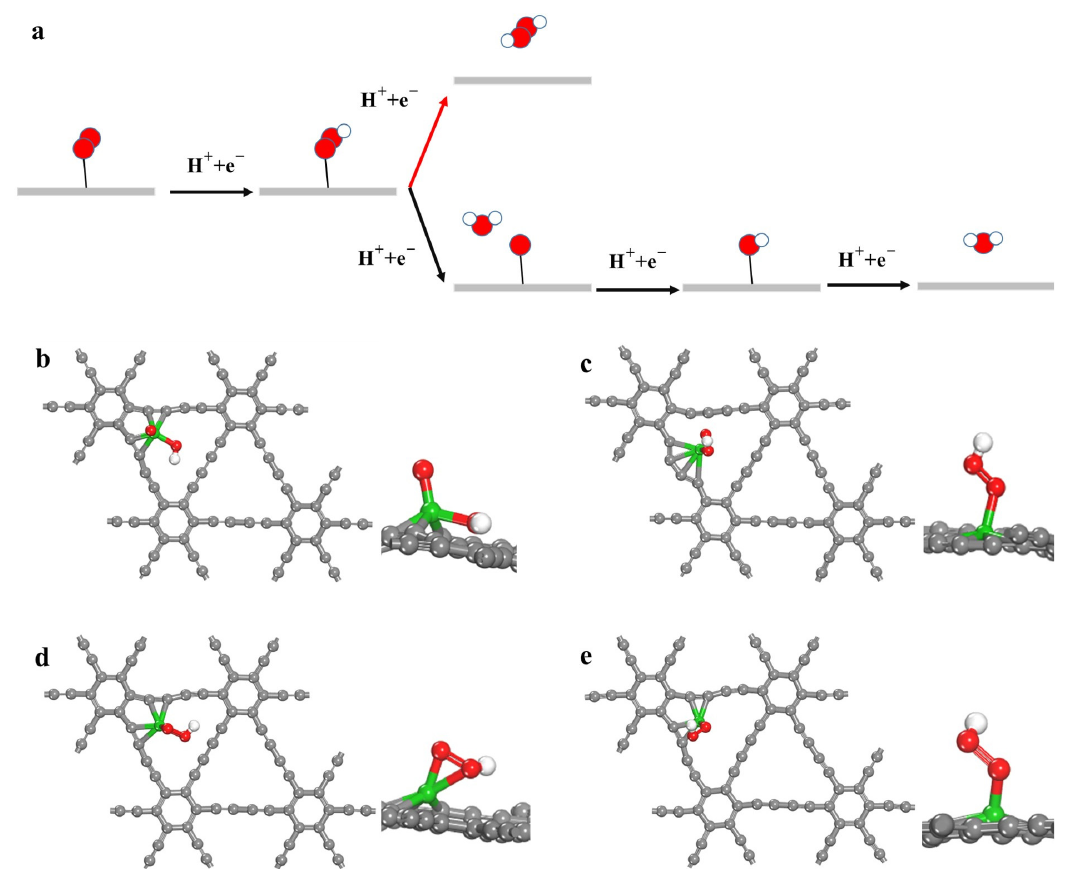
Figure 2. ( a ) Scheme of the 2e − ORR and 4e − ORR pathways. Different adsorption types of intermediate OOH: ( b ) O–O bond cleavage after OOH adsorption to form a *(O + OH) intermediate on TM 1 @GDY (TM = Re, W, Nb, Ta and Mo), ( c ) after OOH adsorption, a single atom is transferred to the acetylene chain on TM 1 @GDY (TM = Sc, Y and Hf), ( d ) side-on adsorption pattern of OOH on TM 1 @GDY (TM = Ti, V, Mn, Zr, Rh and Ir), and ( e ) end-on adsorption mode of OOH on TM 1 @GDY (TM = Pt, Pd, Cu, Co, Ni, Ru, Os, Cr and Fe). Color scheme: H: White; C: Gray; O: Red; Transition metals (TM): Green.